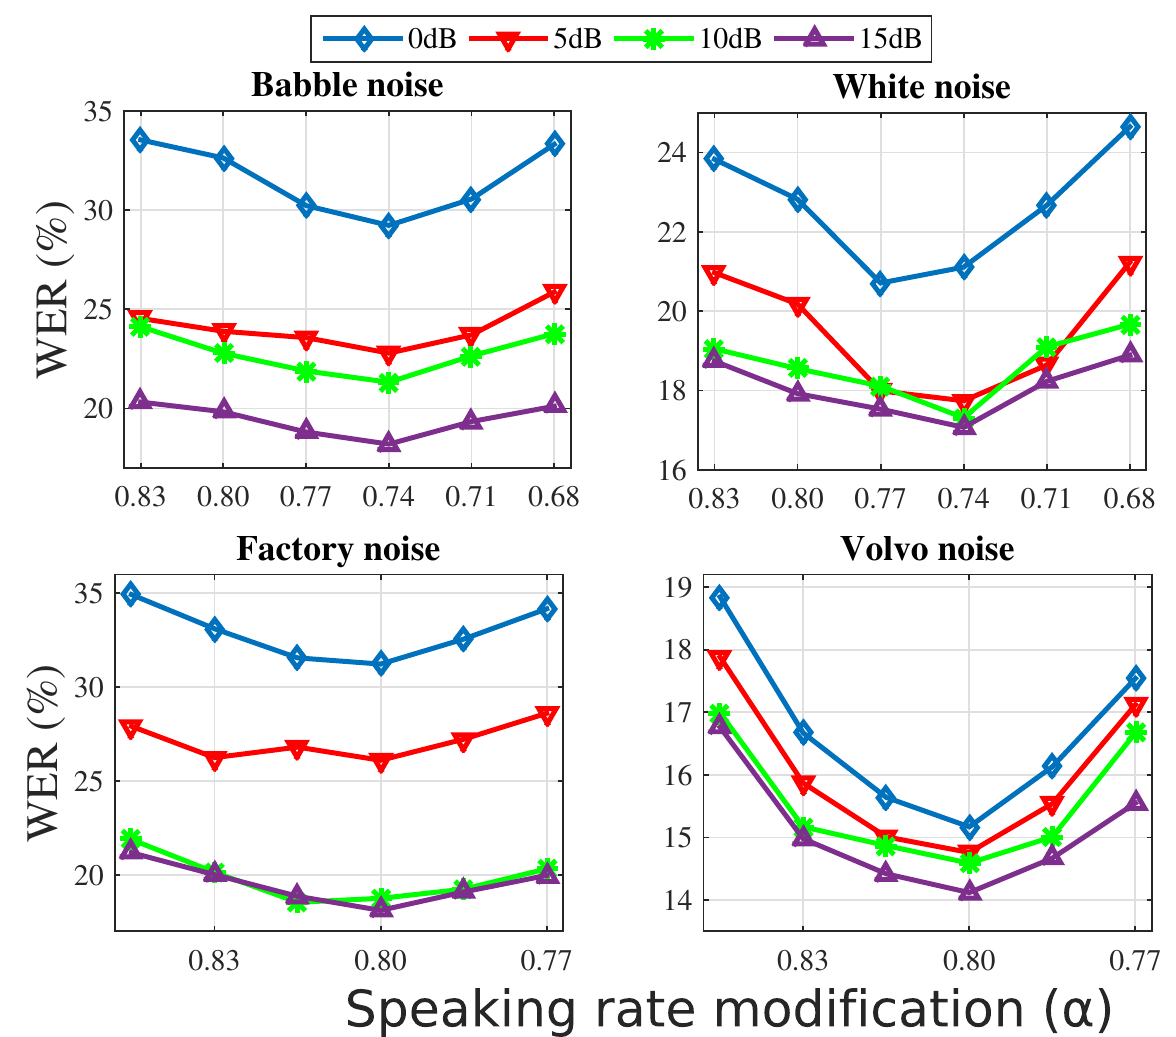
Figure 6. WERs as a function of the speaking rate modification factor α for each of the four noise types and four SNR categories using the validation set. Note that the smaller the value of α (i.e., towards the right end of the x-axis), the larger the strength of the speaking rate